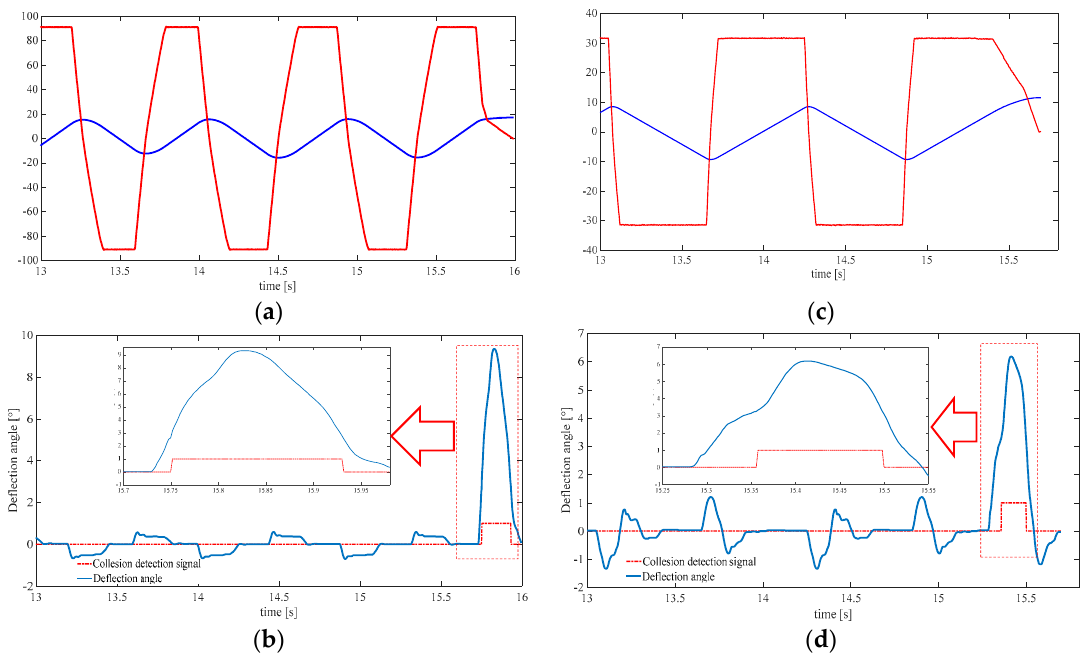
Figure 17. Results of experimental collision tests: ( a ) angular velocity and position of the link in the first test; ( b ) V2SOM deflection angle in the first test; ( c ) angular velocity and position of the link in the second test; ( d ) V2SOM deflection angle in the second test.